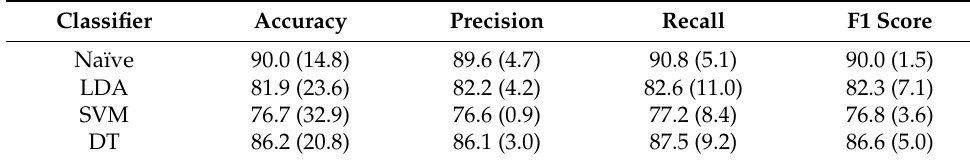
Table 2. Performance metrics for the four different classifiers [Mean (SD)].